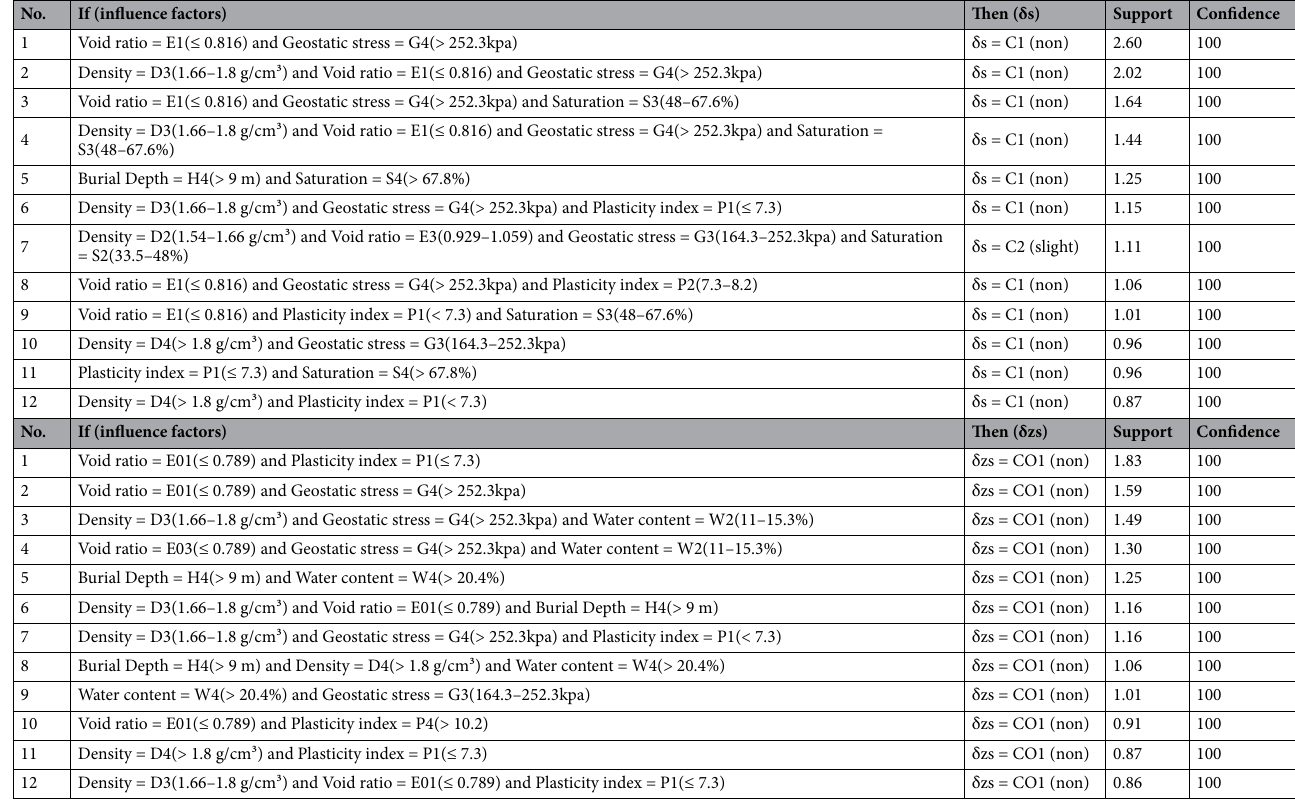
Table 4. Association rules between influence factors and collapsibility (high confidence with relatively high